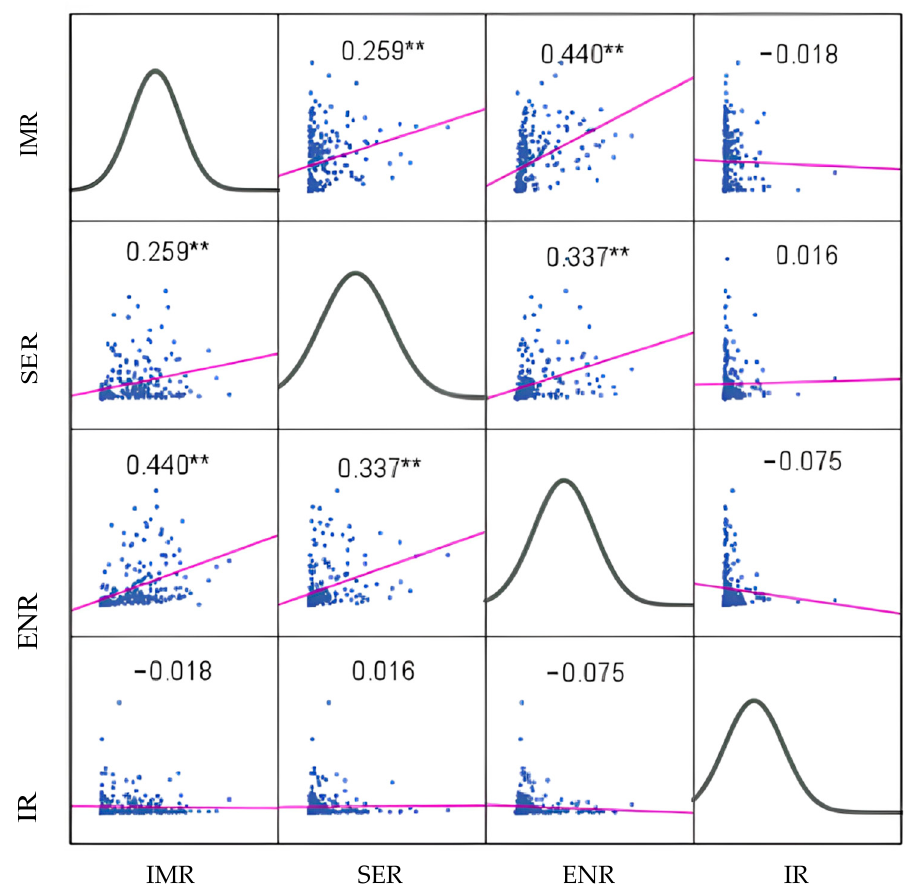
Figure 6. Scatterplots of different non-grain production categories in Liyang. ** p < 0.05. Table 4. Multiple linear regression model results for four given non-grain production